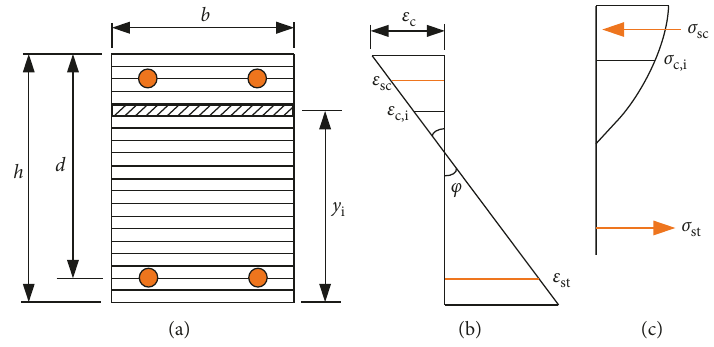
Figure 8: Section analysis. (a) Layered section. (b) Strain distribution. (c) Stress distribution.